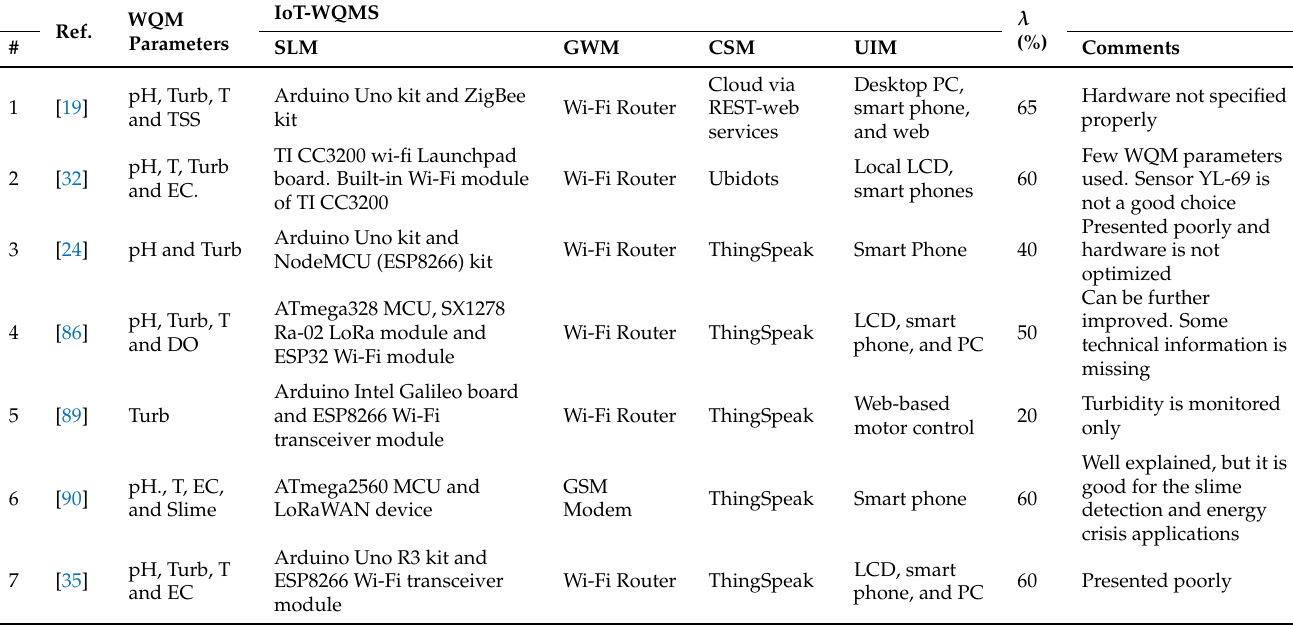
Figure 12. Rating of contemporary IoT-WQMS using proposed empirical rubric. Table 5. Comparison of contemporary